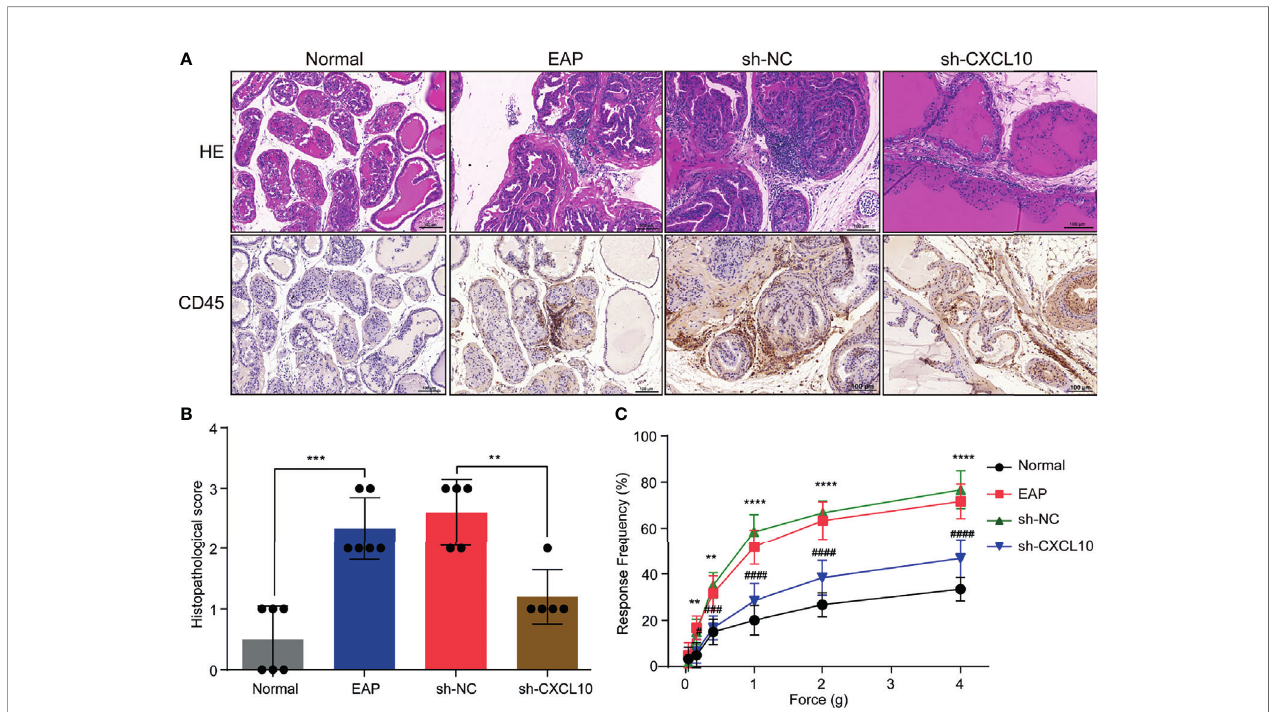
FIGURE 3 | CXCL10 de fi ciency ameliorates EAP severity. (A) Histological evaluation for the degree of in fl ammation for mice in the normal, EAP, sh-NC, and sh-CXCL10 groups. (B) The histopathological scores for mice in the normal, EAP, sh-NC, and sh-CXCL10 groups. (C) Pain response test for mice in the normal, EAP, sh-NC, and sh-CXCL10 groups. Data are shown as mean ± SD by unpaired, two-tailed Student ’ s t -test analysis. ** P < 0.01; *** P < 0.001; **** P < 0.0001; # P < 0.05; ### P < 0.001; #### P <